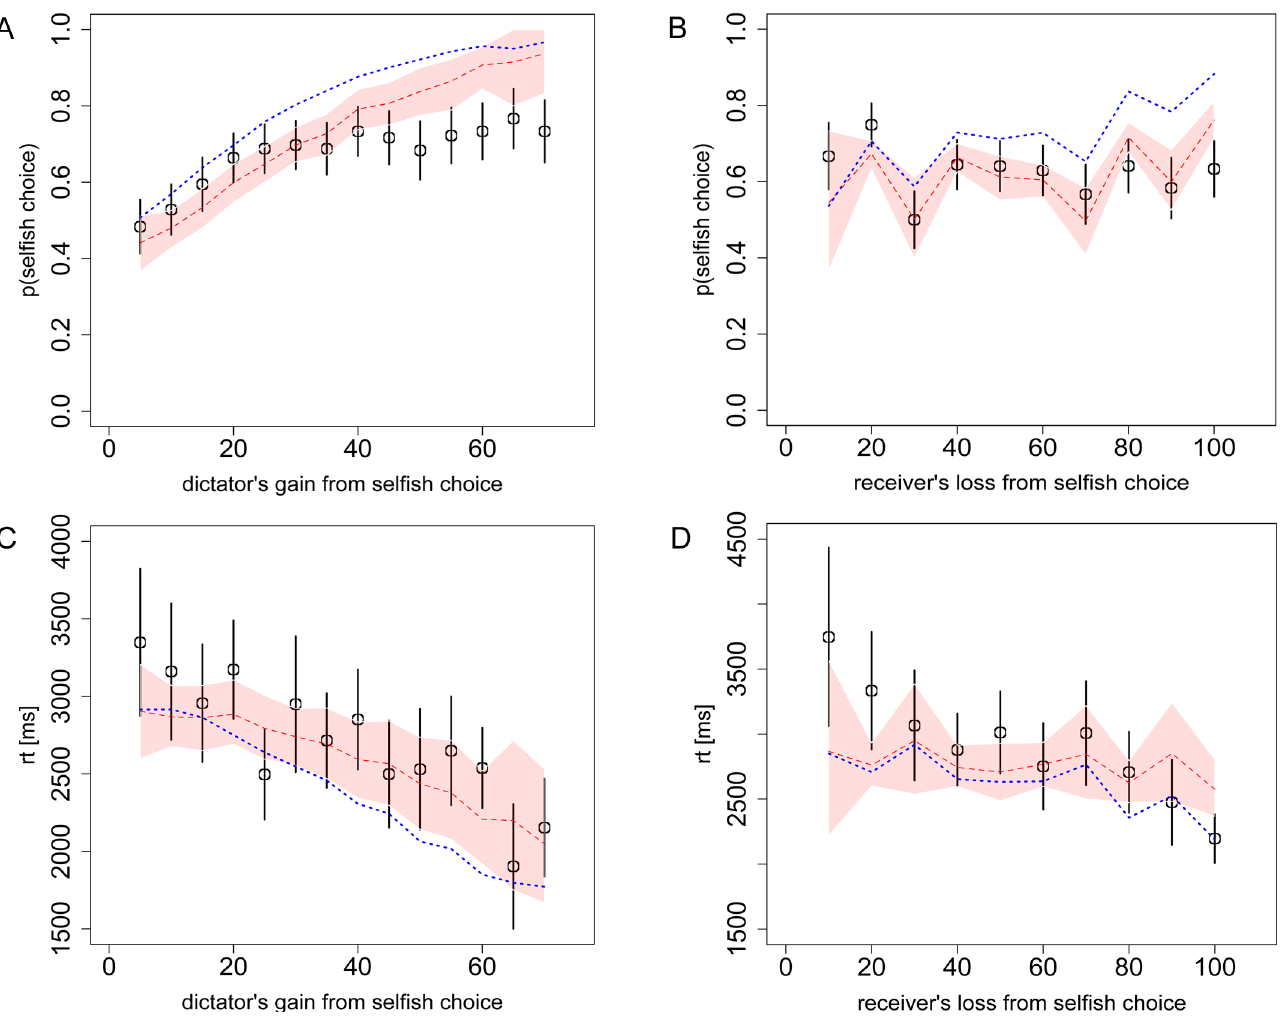
Fig 4. Choices and reaction times from Task 3 (Dictator game). A) The probability of the dictator choosing the selfish option as a function of his own payoff gain from the selfish option, relative to the fairer option, and B) as a function of the receiver ’ s loss from the selfish option. C) The dictator ’ s RT as a function of his own payoff gain from the selfish option, and D) as a function of the receiver ’ s loss from the selfish option. Black circles indicate the aggregate subject data with bars representing s.e.m. Red dashed lines indicate the DDM predictions with 95% confidence intervals. The overlap of these confidence intervals with the data ’ s standard error bars indicates excellent model predictions. Blue dotted lines indicate the alternative DDM with θ = 0.15, which would be the prediction from the widely-used Fehr-Schmidt model of social preferences. error magnitude: 9.1% for the dictator ’ s gain (Fig 4A), 5.6% for receiver ’ s loss (Fig 4B), RT: mean error magnitude: 6.5% for the dictator ’ s gain (Fig 4C), 8.1% for receiver ’ s loss (Fig 4D)).